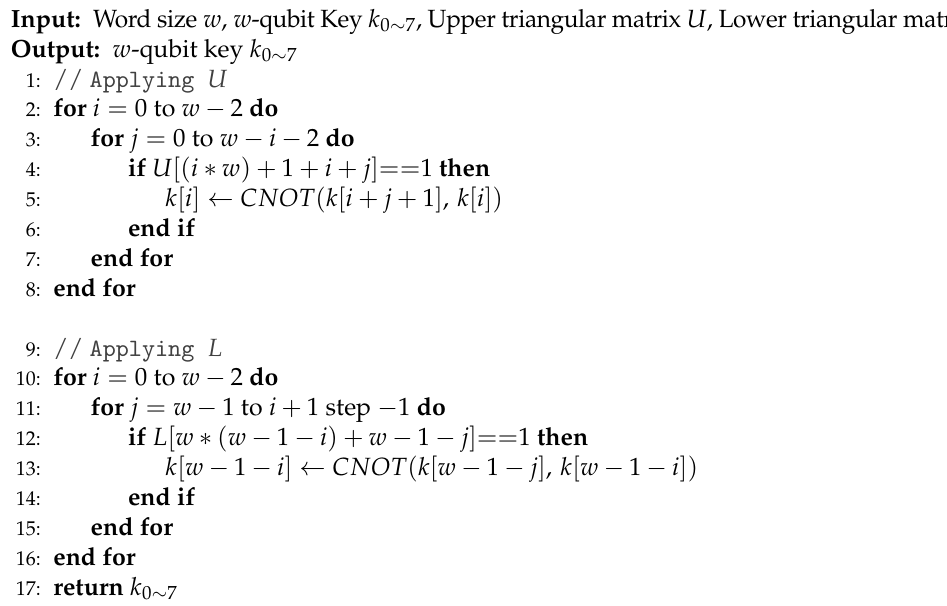
Algorithm 1 Quantum implementation of LU factorization.